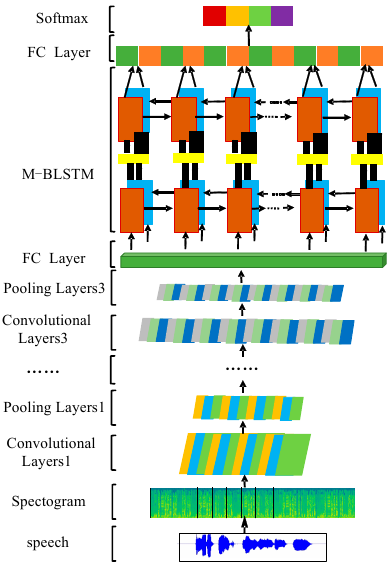
Figure 3. Convolutional recurrent neural network (CRNN) model.